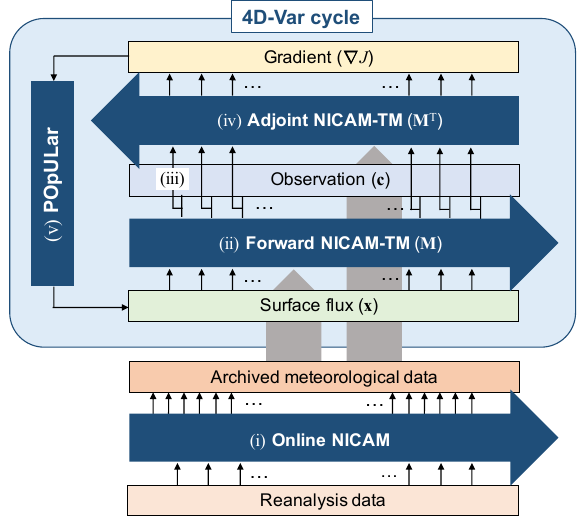
Figure 1. A schematic figure of NICAM-TM 4D-Var. A Roman numeral indicates each calculation described in the